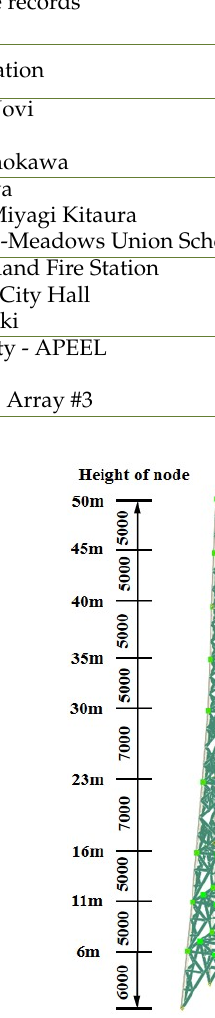
Table 10. Selected earthquake records